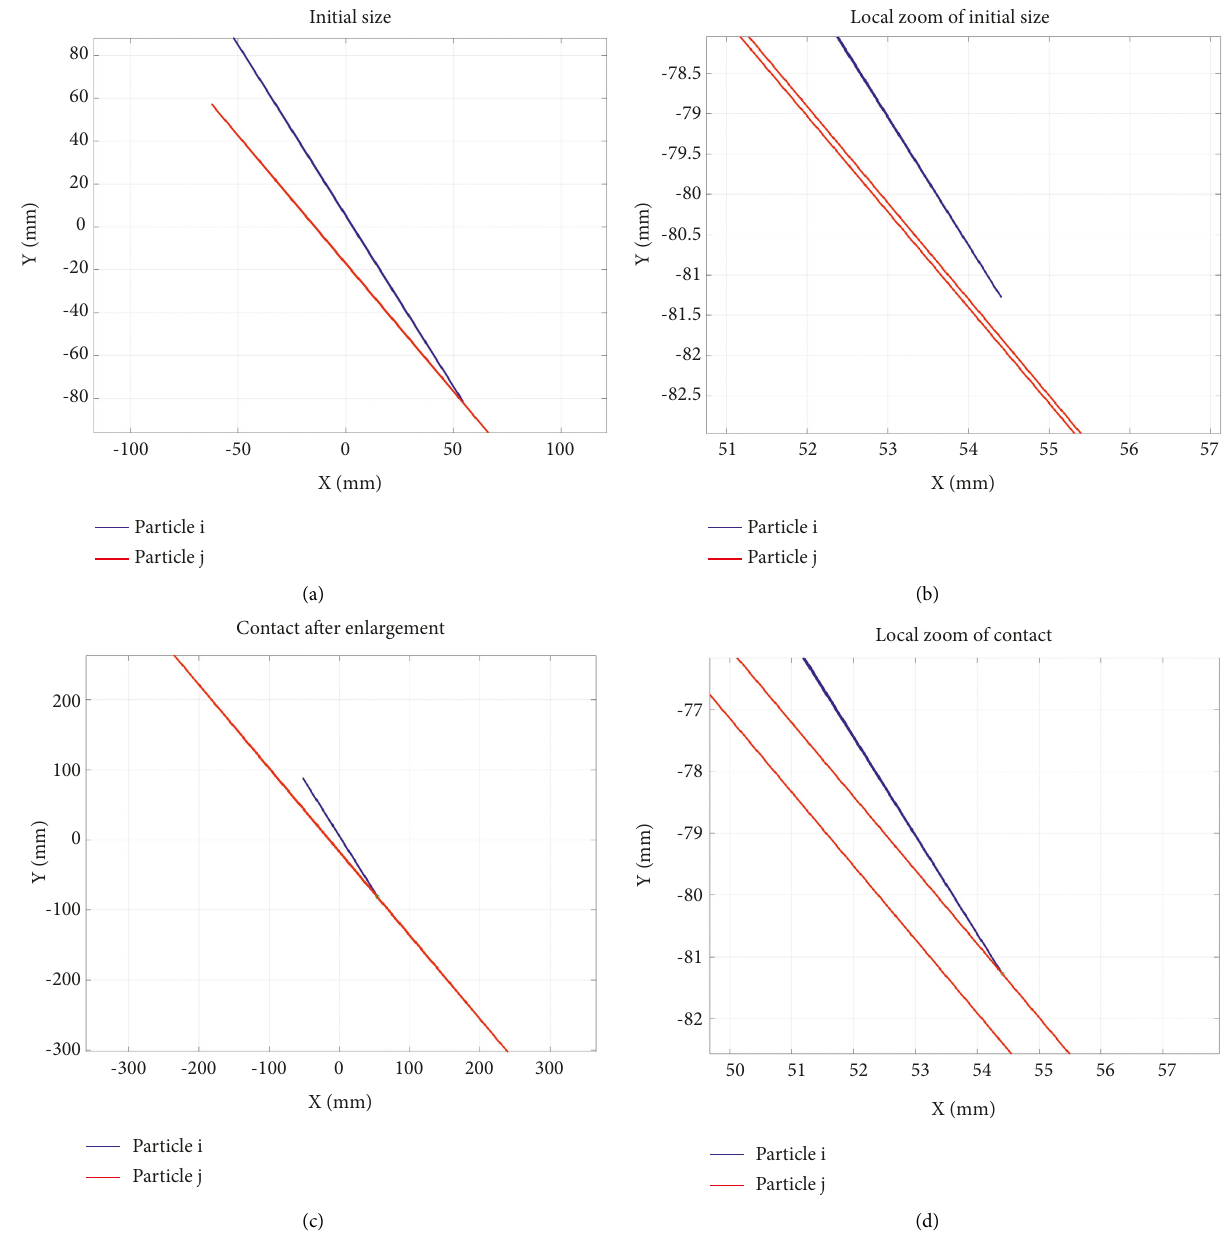
Figure 16: Contact detection between two ellipses with large eccentricity. (a) Initial size. (b) Local zoom of the initial size. (c) Contact after enlargement. (d) Local zoom of